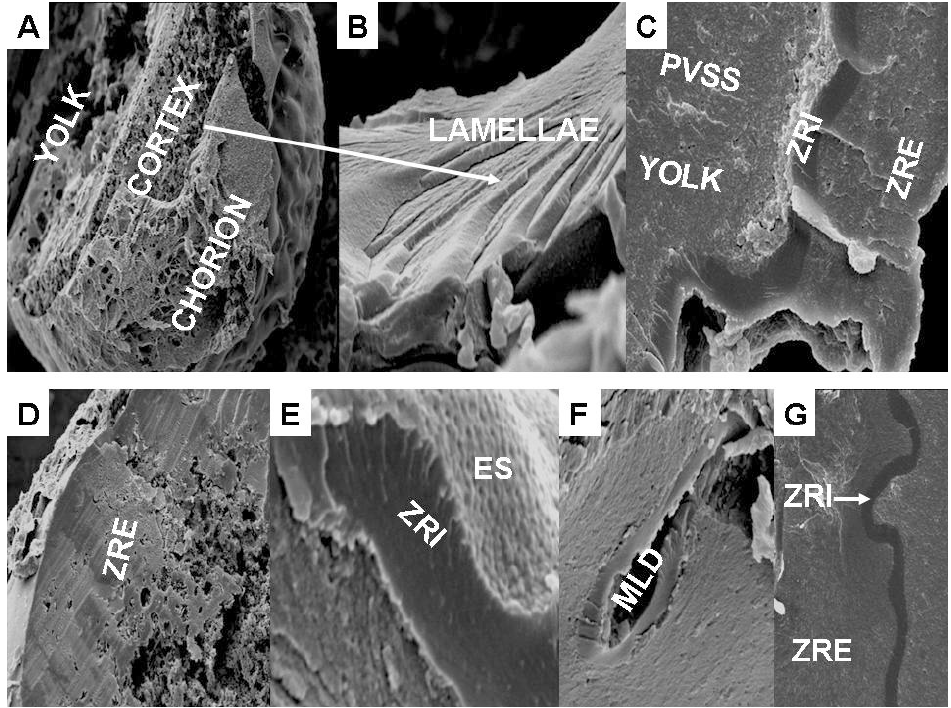
F IG . 11. – Fractured parts of the fertilised eggs Clarias gariepinus showing the chorion layers and the cortex. Lamellar nature of ZRI was evi- dent (A: × 150; B: × 5000). The tubular structure of ZRI and to some extent ZRE and secretions in PVS (PVSS) (C: × 2000). Disappearance of ZRE in the vegetal pole and at micropyle-like depression (MLD) (E: × 10000; F: × 2000). Note the tubular nature of ZRI (E). ES: egg sur- face. The thickness-relationship between ZRE and ZRI especially in the micropylar region (G: × 1500), the great thickness of ZRE in the animal region (D: × 350) and the brushed inner side ZRI